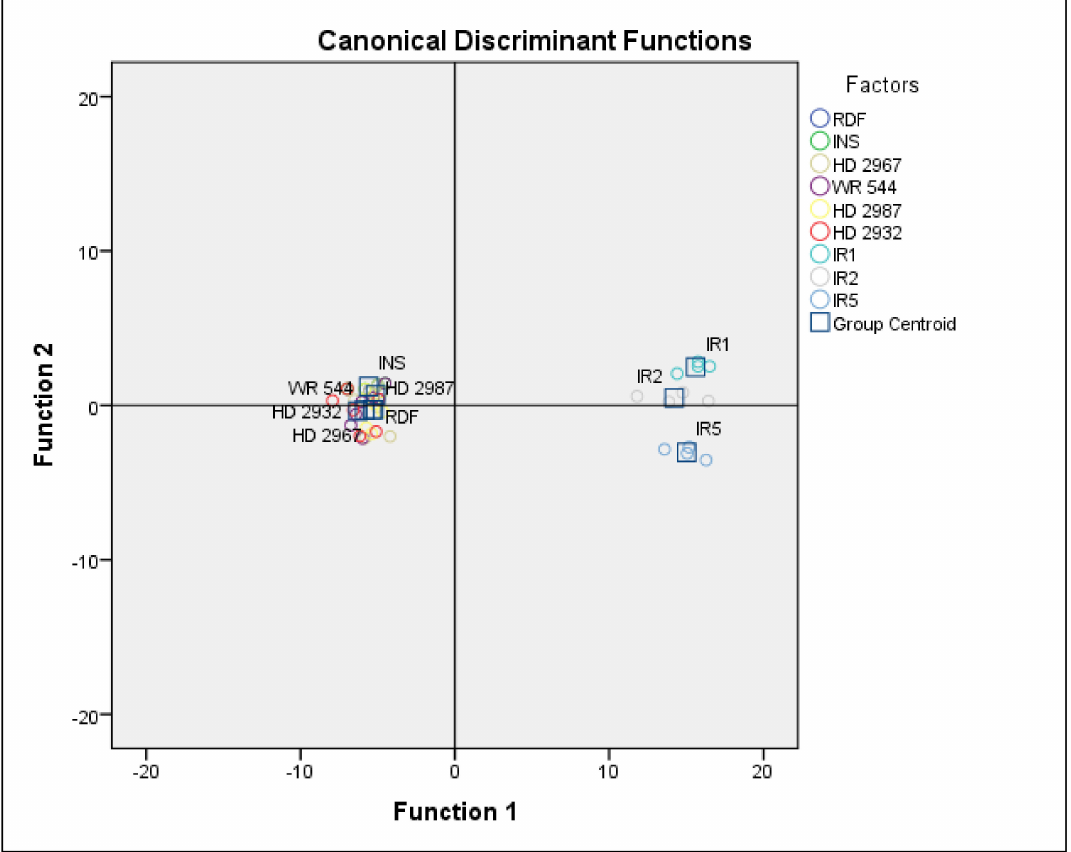
Figure 1. Bi-plot of canonical discriminant functions for separation of different factor